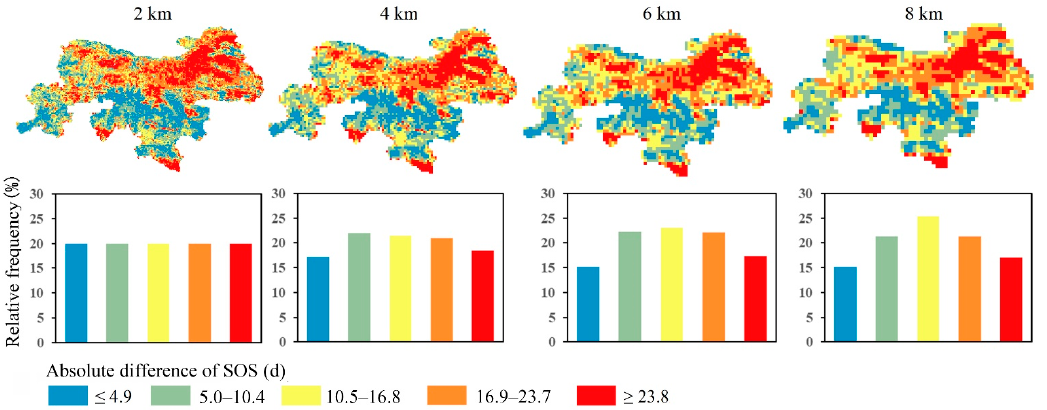
Figure 11. Absolute differences between the up-scaled results from the 250 m SOSs obtained by SG-filtering and 1000 m SOSs obtained by AG-filtering at different scales. Days 4.9, 10.4, 16.8, and 23.7 correspond to the 20%, 40%, 60%, and 80% cumulative frequency of the 2 km SOS difference,